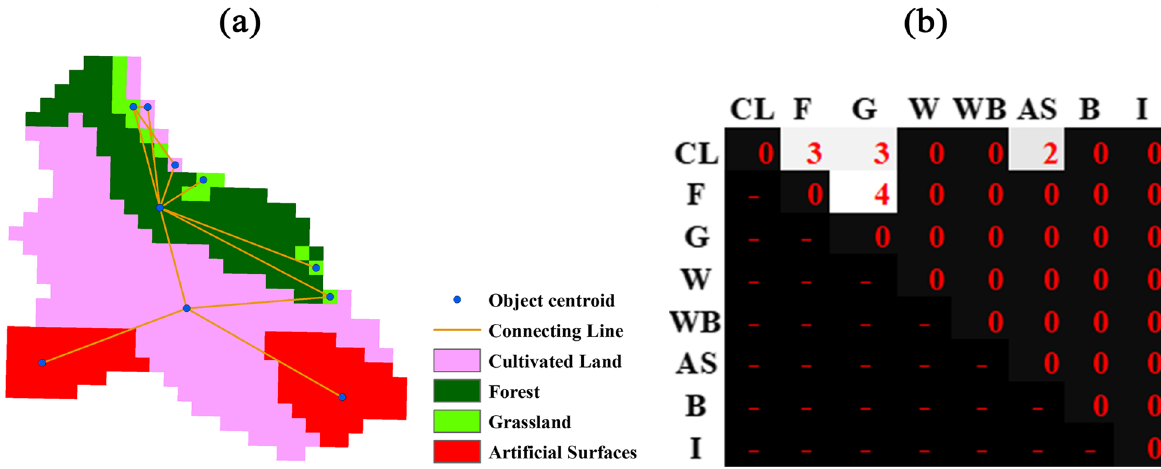
Fig. 3 a land cover map and b LCSC